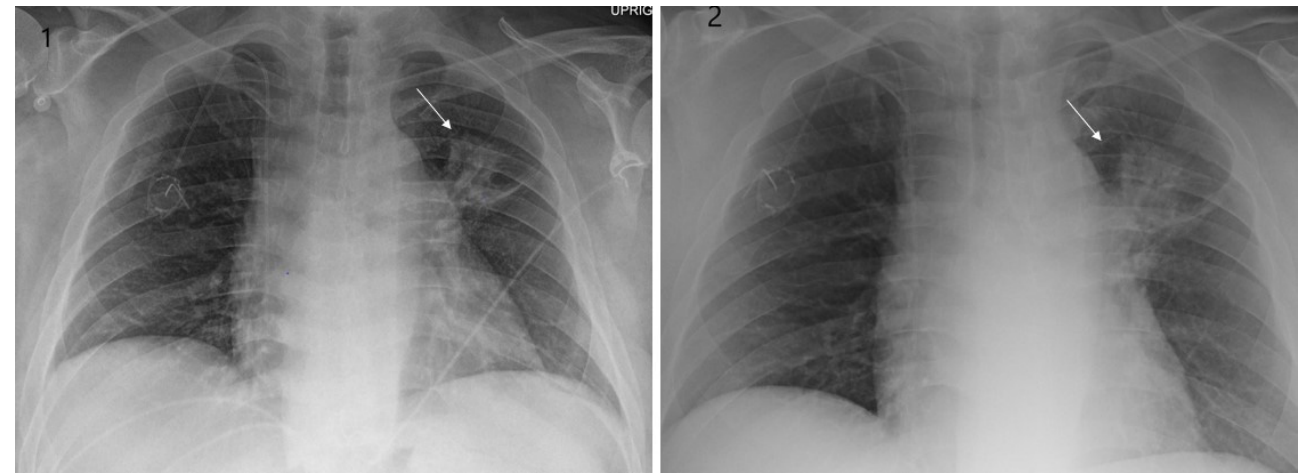
Figure 1. Chest X-ray showing radiation pneumonitis Image 1—Frontal chest X-ray showing left upper lobe mass (arrow), the patient also had a right internal jugular port placed. Image 2—Post radiation treatment frontal chest X-ray showing increasing alveolar and interstitial opacities in the left upper lobe and in the left lower lobe in a patient suspected of radiation pneumonitis.